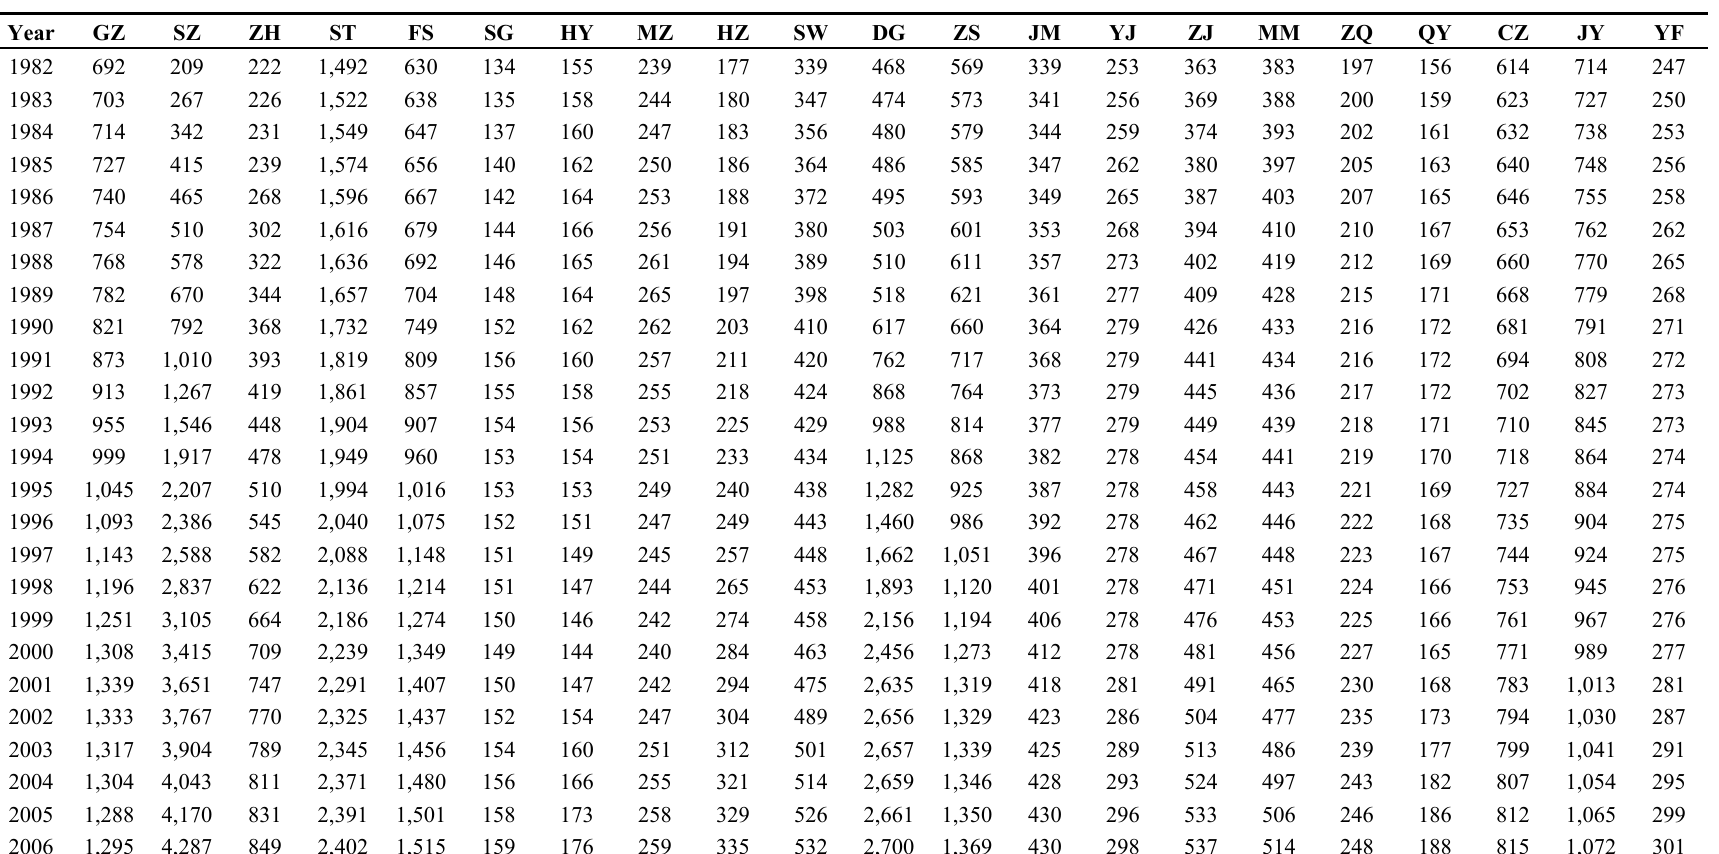
Table A1. The average annual permanent population density of 21 cities in Guangdong Province from 1982 to 2006 (person·km − 2